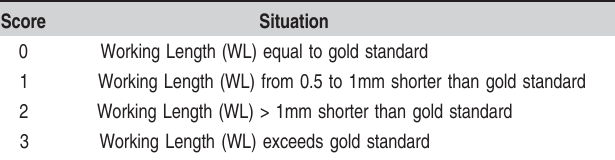
Table 1 – Working length scoring system.